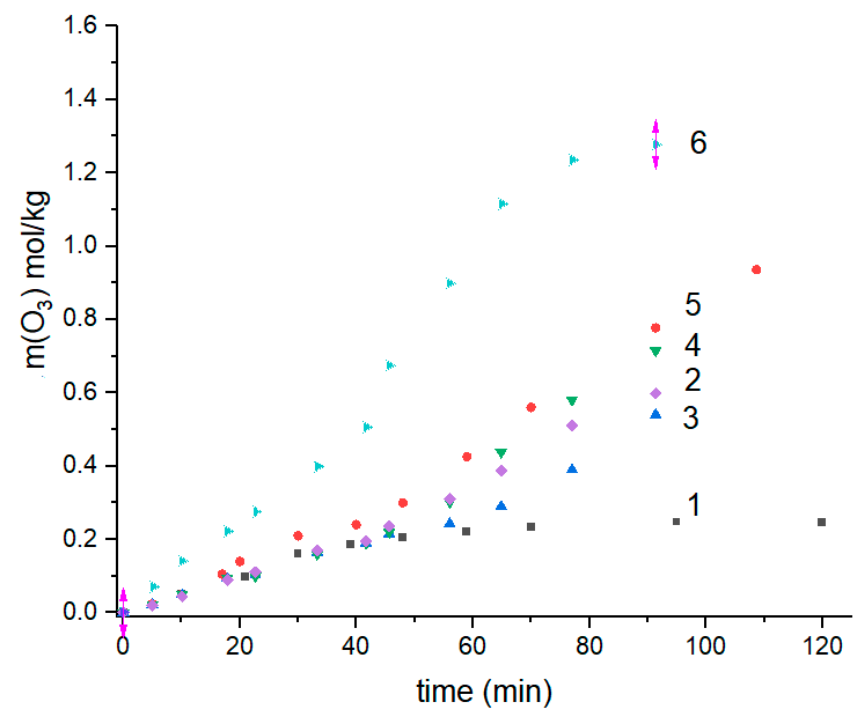
Figure 5. Ozone consumption by the ultrathin fibers at different wt.% of biopolymers PHB:PLA: 1—100:0; 2—0:100; 3—70:30; 4—30:70; 5—10:90; 6—50:50.